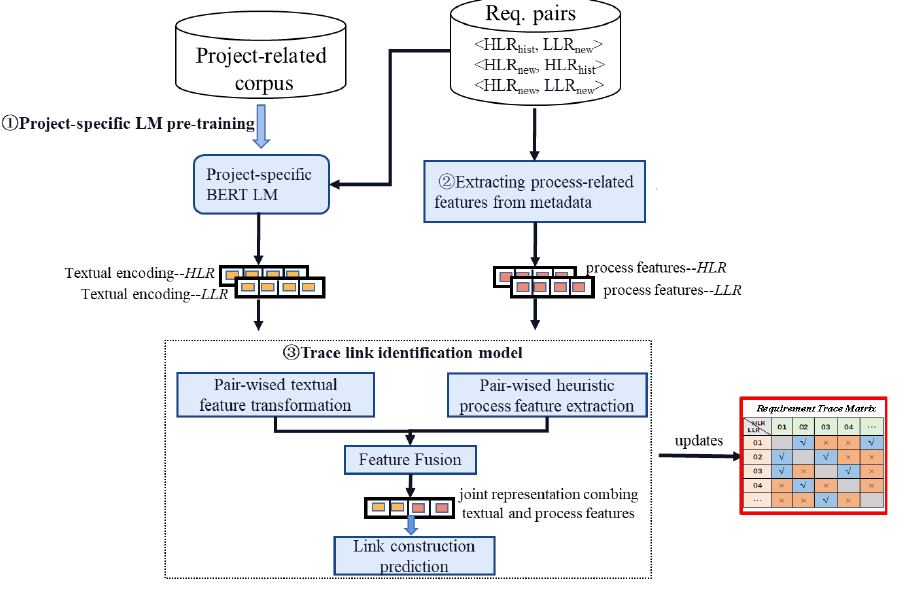
Figure 5. Flowchart of DRAFT.